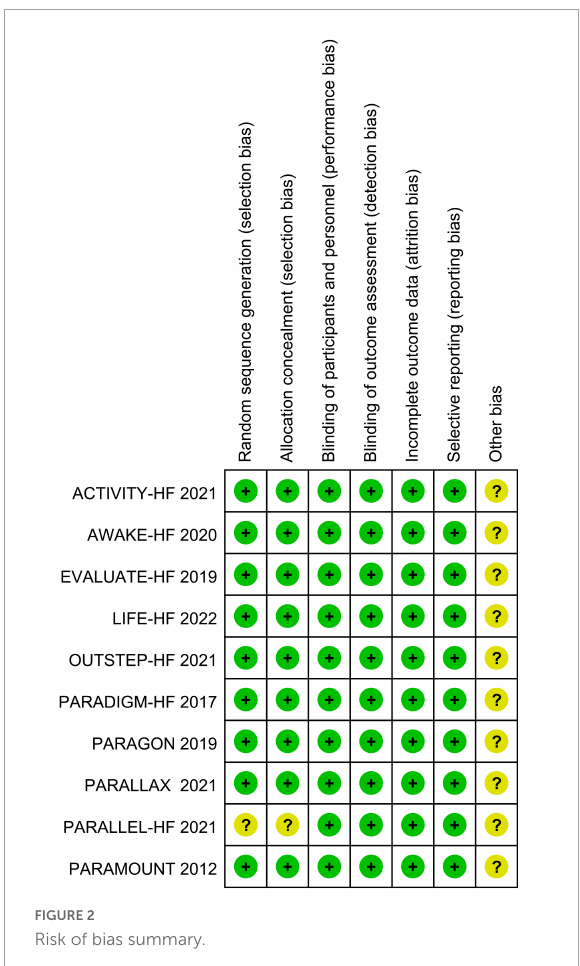
FIGURE2 Risk of bias